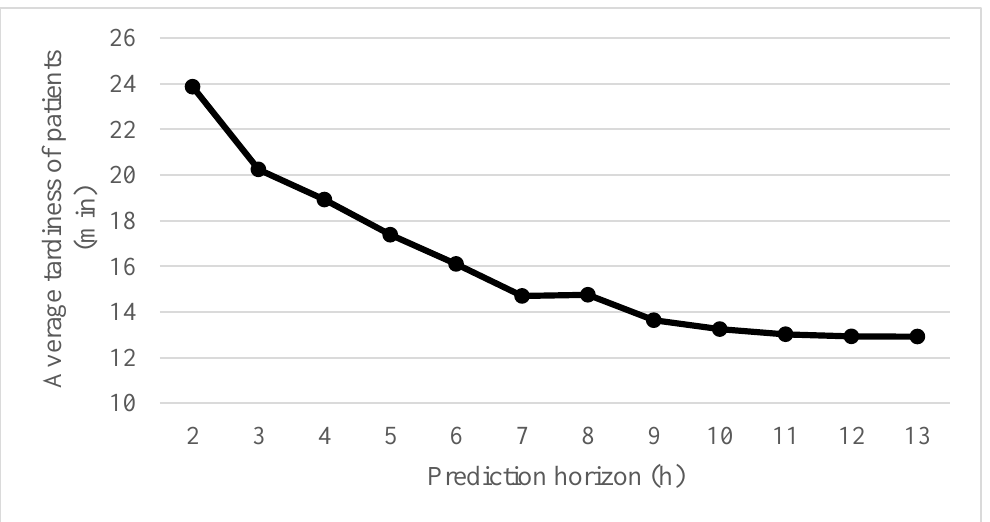
Figure 3. Average tardiness of patients according to the prediction horizon.